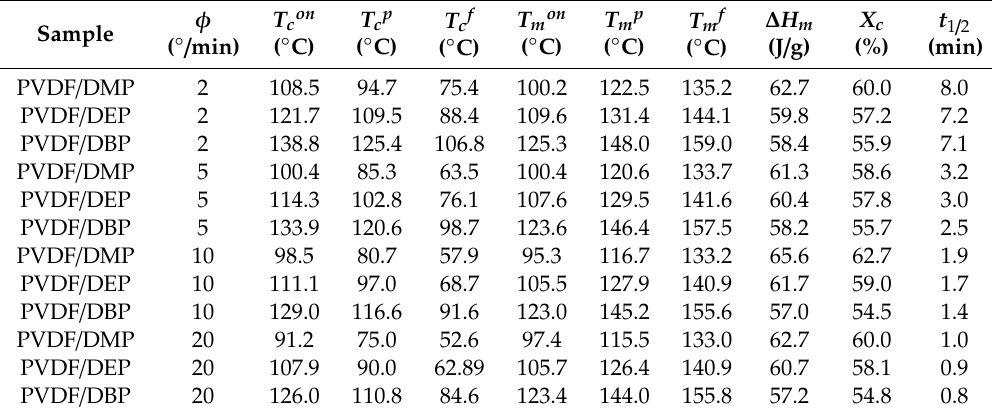
Table 1. DSC crystallization and melting results of PVDF / dialkyl phthalate blends.